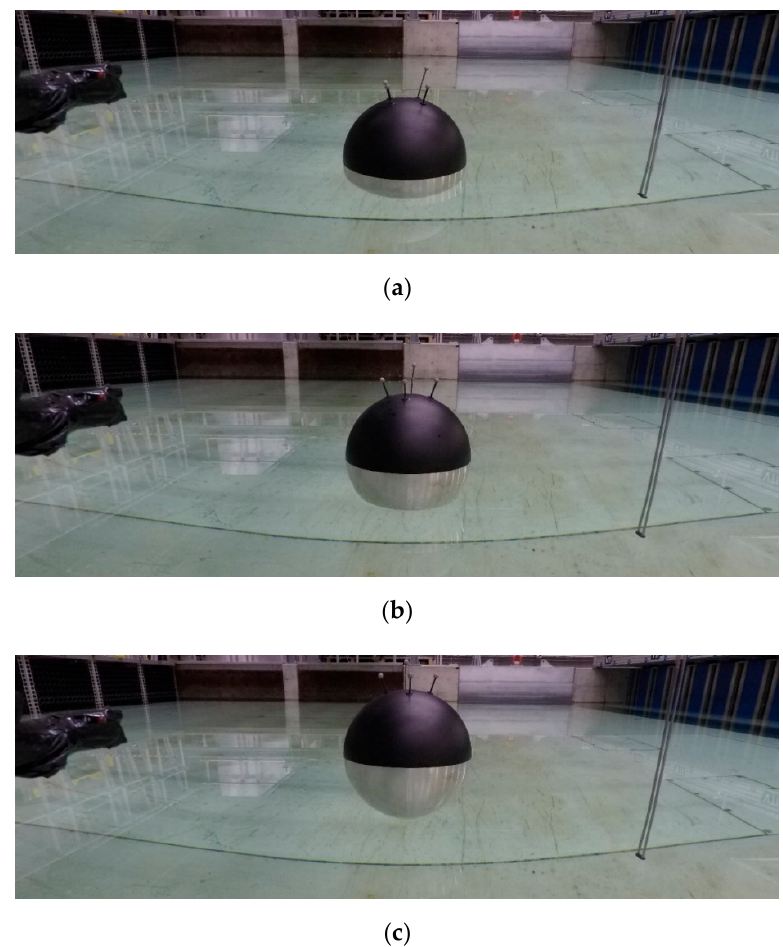
Figure 12. Photos of investigated drop heights: 𝐻 (cid:2868) = 0.1𝐷 ( a ), 𝐻 (cid:2868) = 0.3𝐷 ( b ), and 𝐻 (cid:2868) = 0.5𝐷 ( c ).